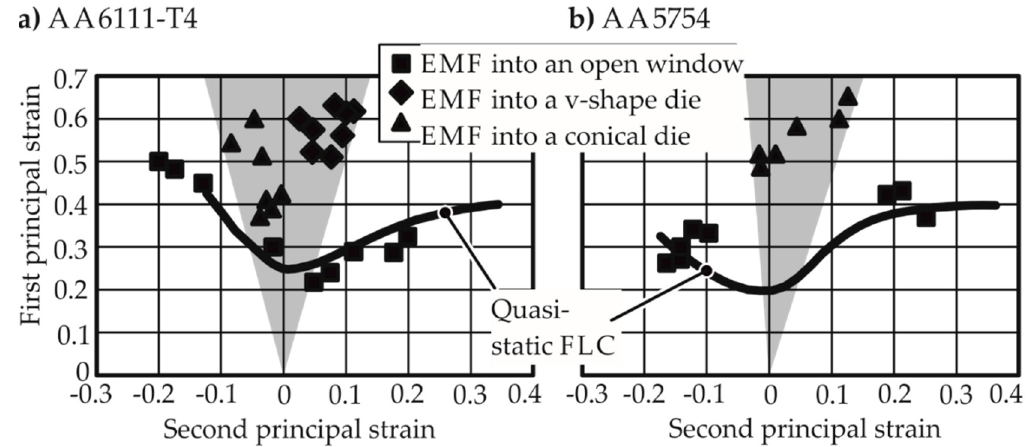
Figure 1. Forming limits reached by Golovashchenko [3] via electromagnetic forming. ( a ) Higher forming limits observed in the closed die forming cases for AA 6111-T4; ( b ) Marginally higher formability obtained for AA 5754 in open die forming.